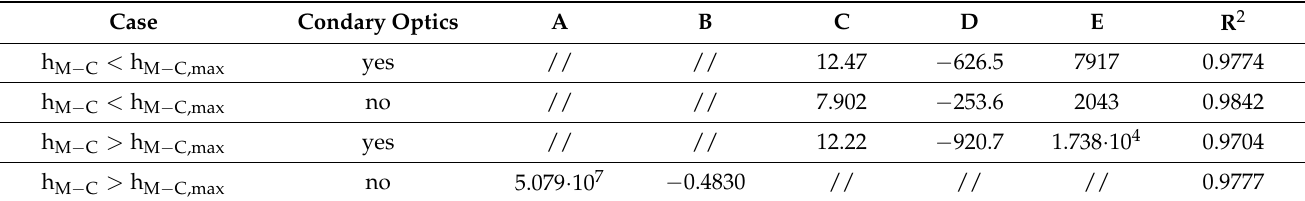
Table 3. Values of the coefficients of the experimental equations describing the trends of C opt for the spherical mirror. Secondary Case Optics